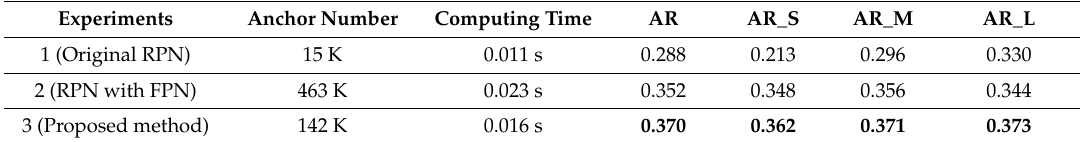
Table 3. Performance of RPN in different experiments.